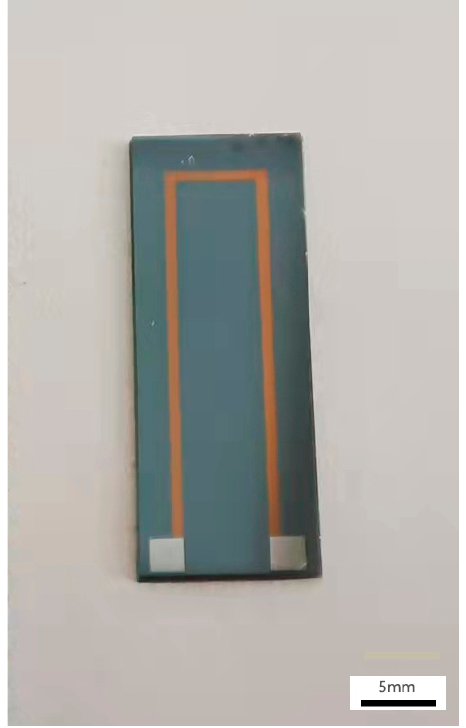
Figure 2. The fabricated TFTC by MEMS process.